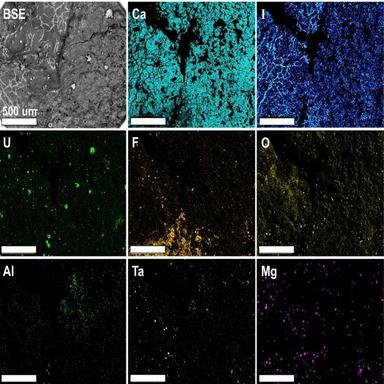
Image and elemental X-ray maps of an area with a Ca/F-rich surface with Ca/I-rich protrusions.